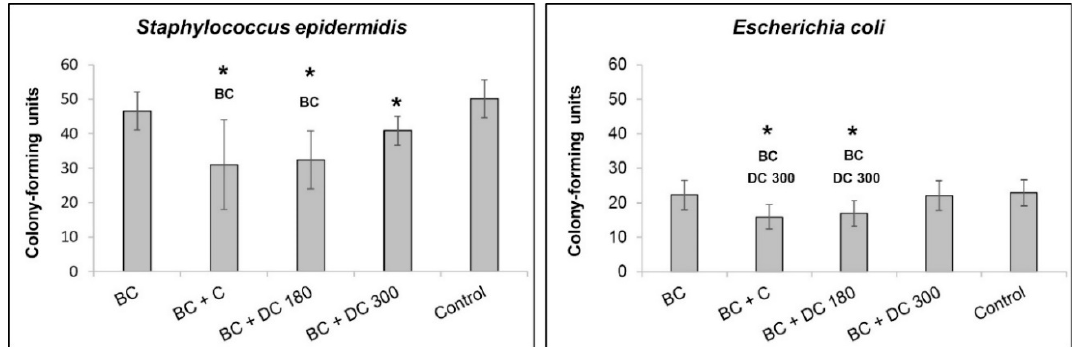
Figure 9. Antimicrobial activity of pristine bacterial nanocellulose (BC) and nanocellulose loaded with curcumin (BC + C), or with curcumin degraded at 180 ◦ C (BC + DC 180) or at 300 ◦ C (BC + DC 300) at a concentration of 0.5 mg / mL. The pure medium with bacteria was used as the control sample. The antimicrobial activity is presented for S. epidermidis and for E. coli . Arithmetic mean ± SD from 12–16 measurements for each experimental group. Nonparametric Kruskal–Wallis one way analysis of variance on ranks, Dunn’s method, statistical significance ( p ≤ 0.05; depicted above the columns): * BC and DC 300 compared with bacteria cultivated in the control medium, in the presence of BC and BC + DC 300, respectively.